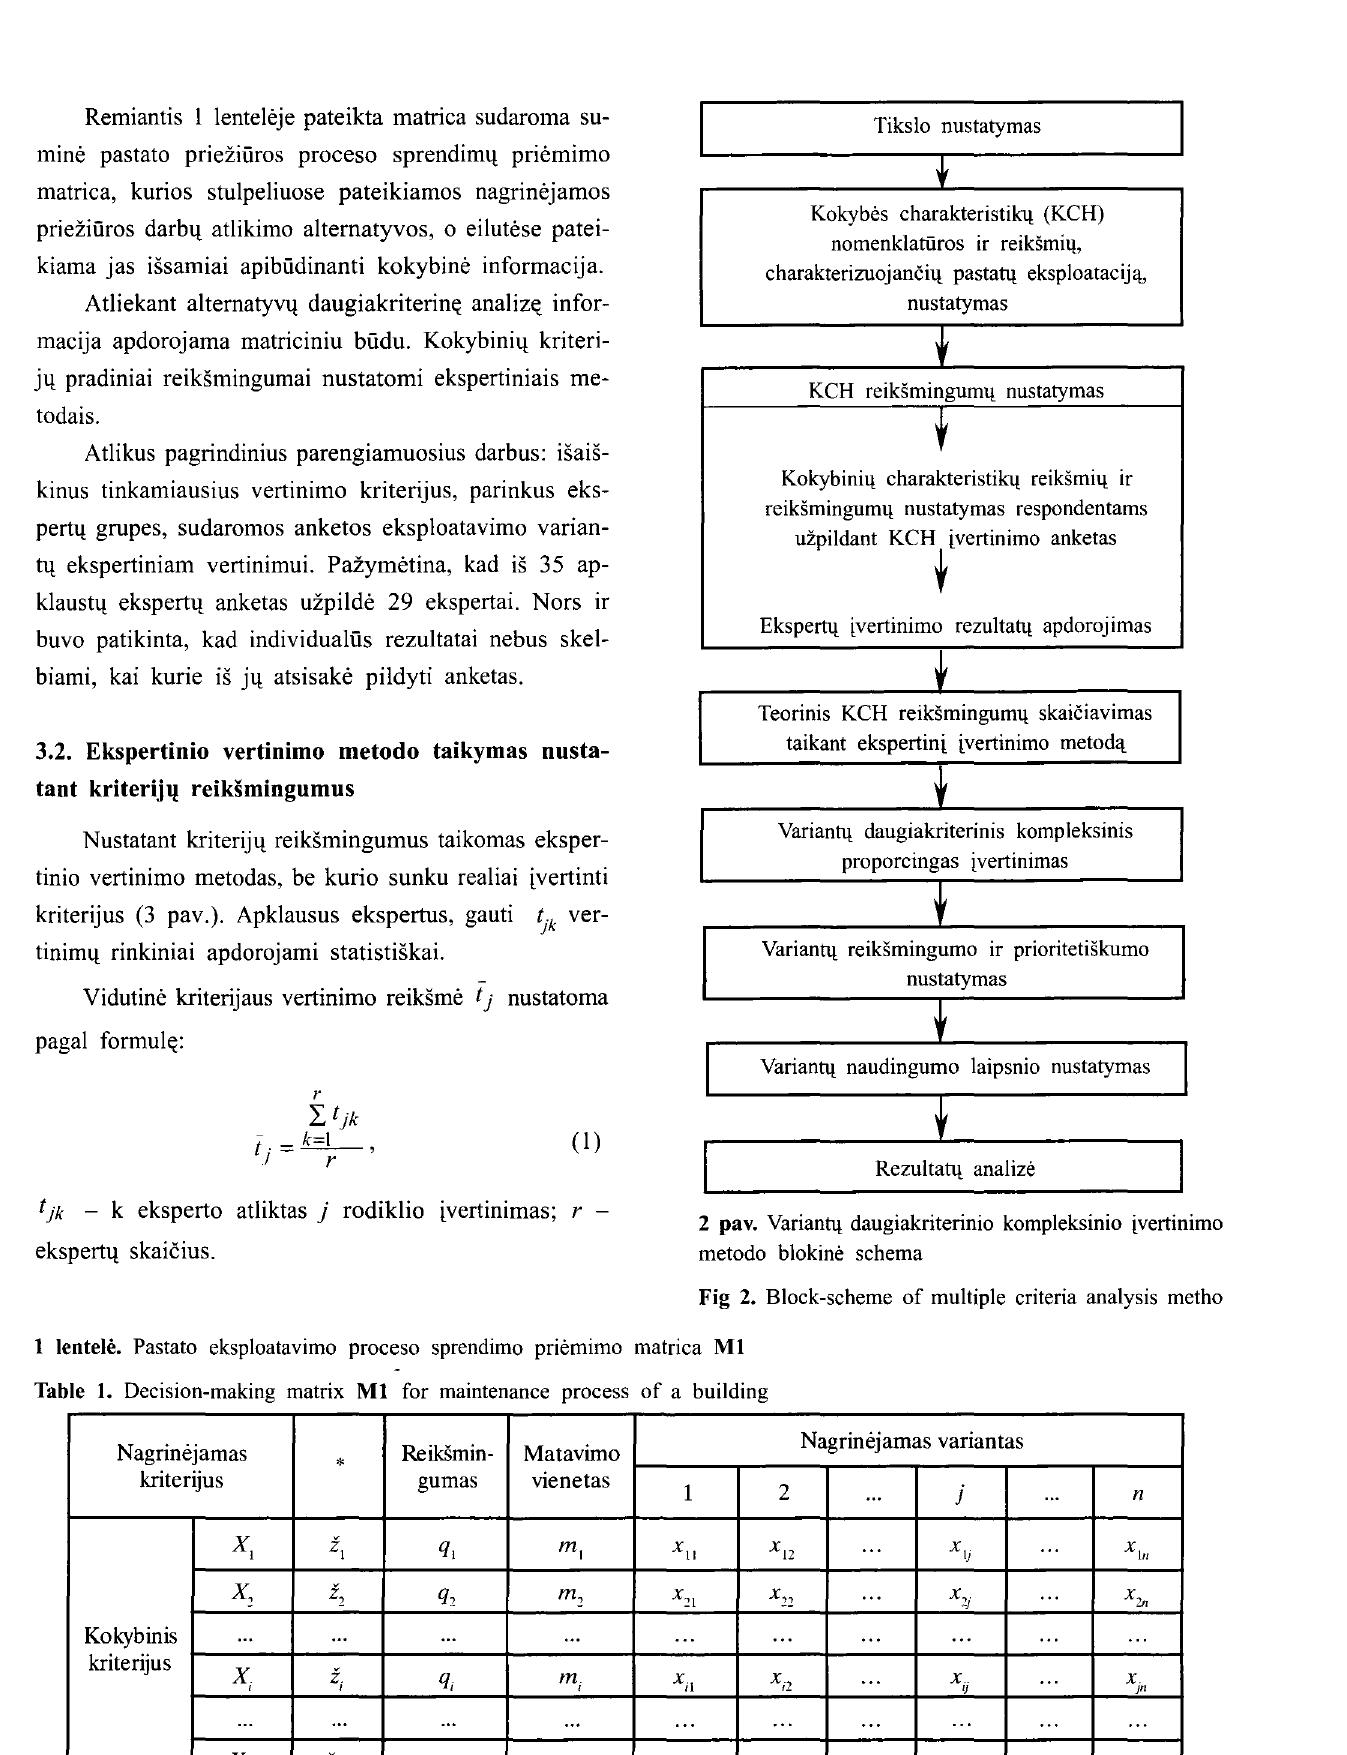
Fig 2. Block-scheme of multiple criteria analysis metho